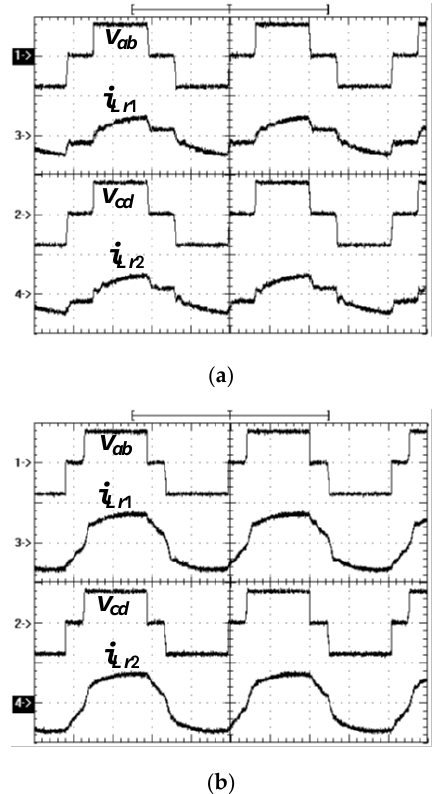
Figure 8. Measured waveforms of v ab , v cd , i Lr1 and i Lr2 at 800 V input ( a ) 20% load (v ab , v cd : 500 V/div;